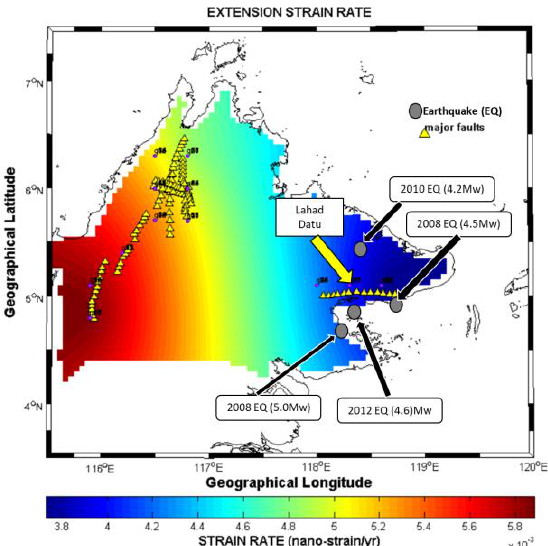
Figure 18. Strain rate (Extension) map contour over Sabah (2004-2013).